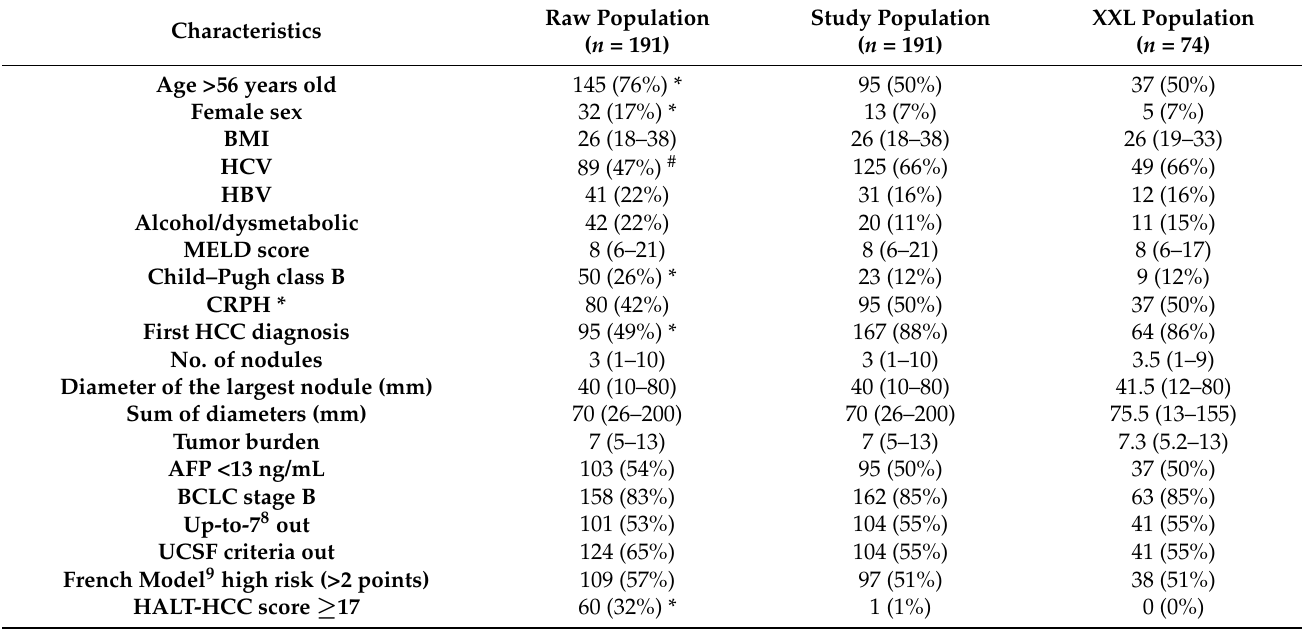
Table 2. Characteristics of the study group before and after weighting, and comparison with the XXL